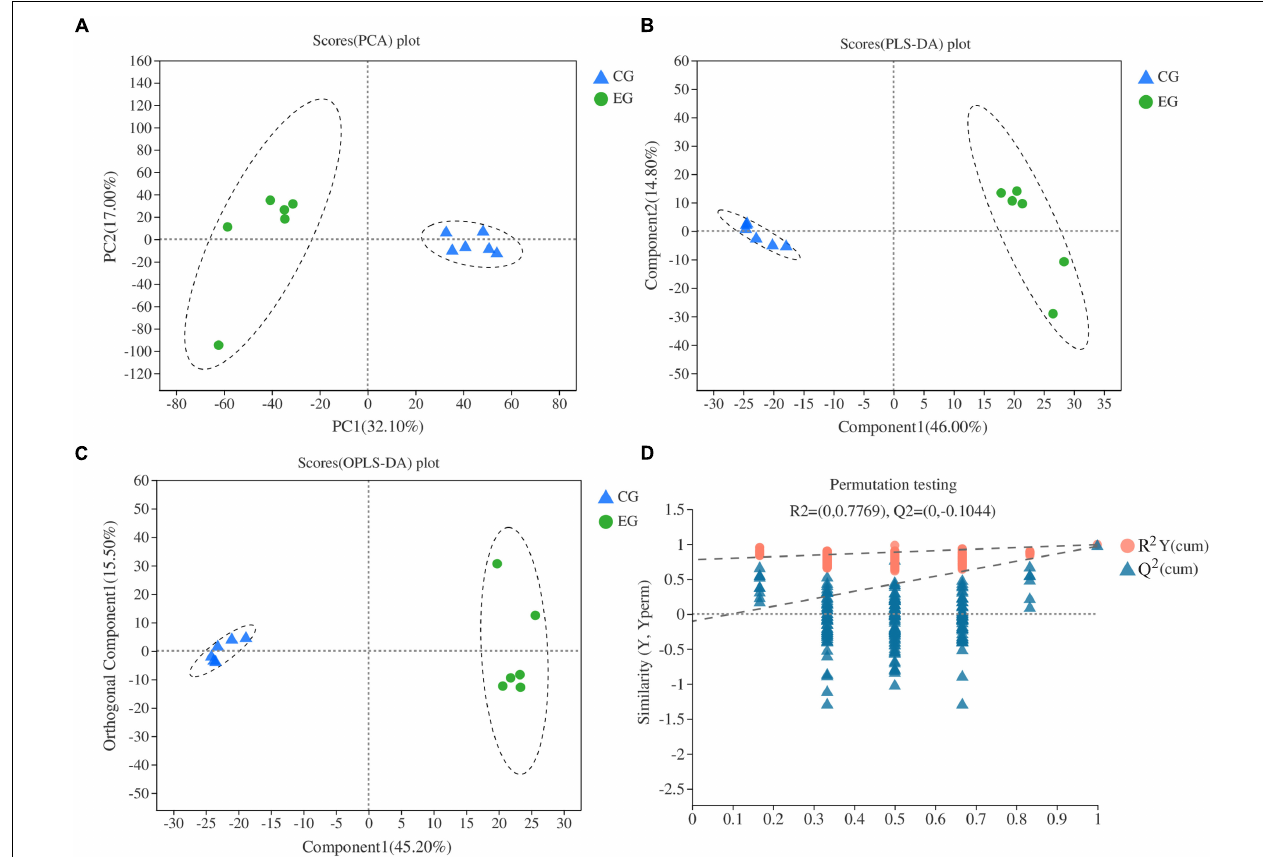
FIGURE 4 | Multivariate statistical score and response-sorting test diagram in two NILs. (A) PCA; (B) PLS-DA; (C) OPLS-DA; (D) response-sorting test of the OPLS-DA model. EG, experiment group (NIL-D); CG, control group